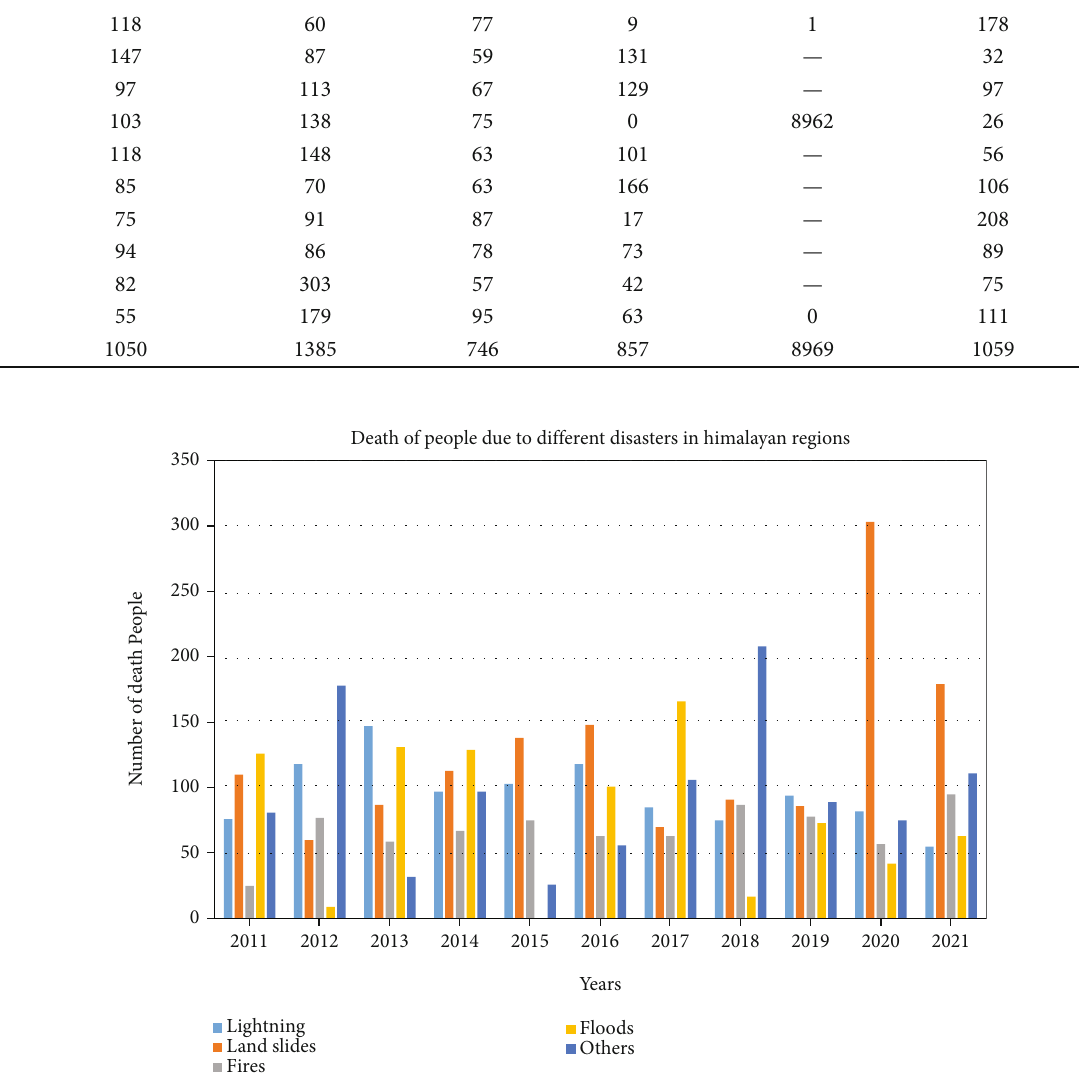
Figure 1: Death of people due to di ff erent disasters in Himalayan regions during the period of January 2011 to December